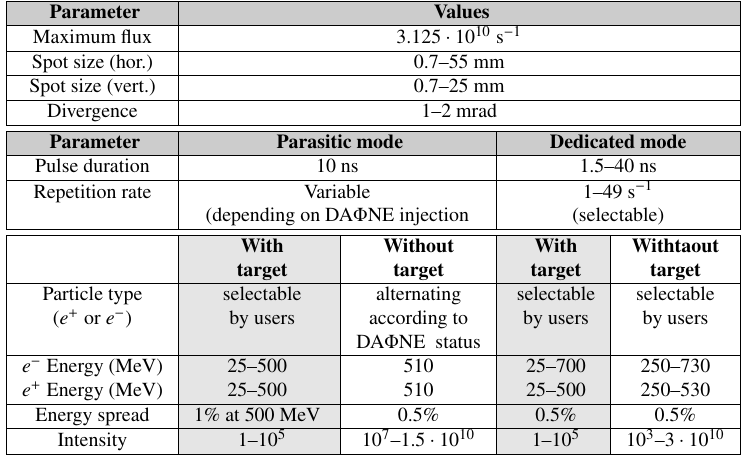
Table 1. Beam parameters achievable in all possible operation modes at the end of the BTF